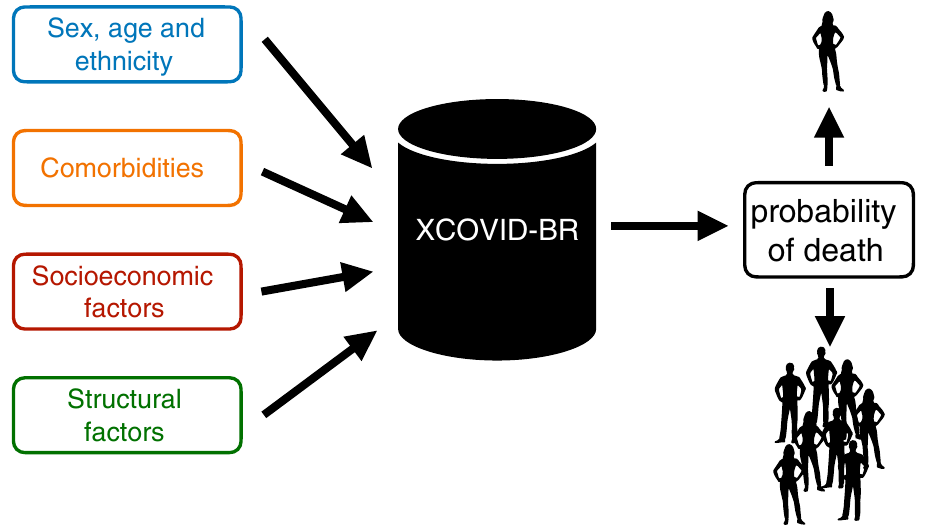
Figure 1. The XCOVID-BR machine learning model. XCOVID-BR takes as input a range of medical, socioeconomic and structural factors and returns as output the probability of death by COVID-19. XCOVID-BR can be applied to individuals, groups or whole sections of the Brazilian